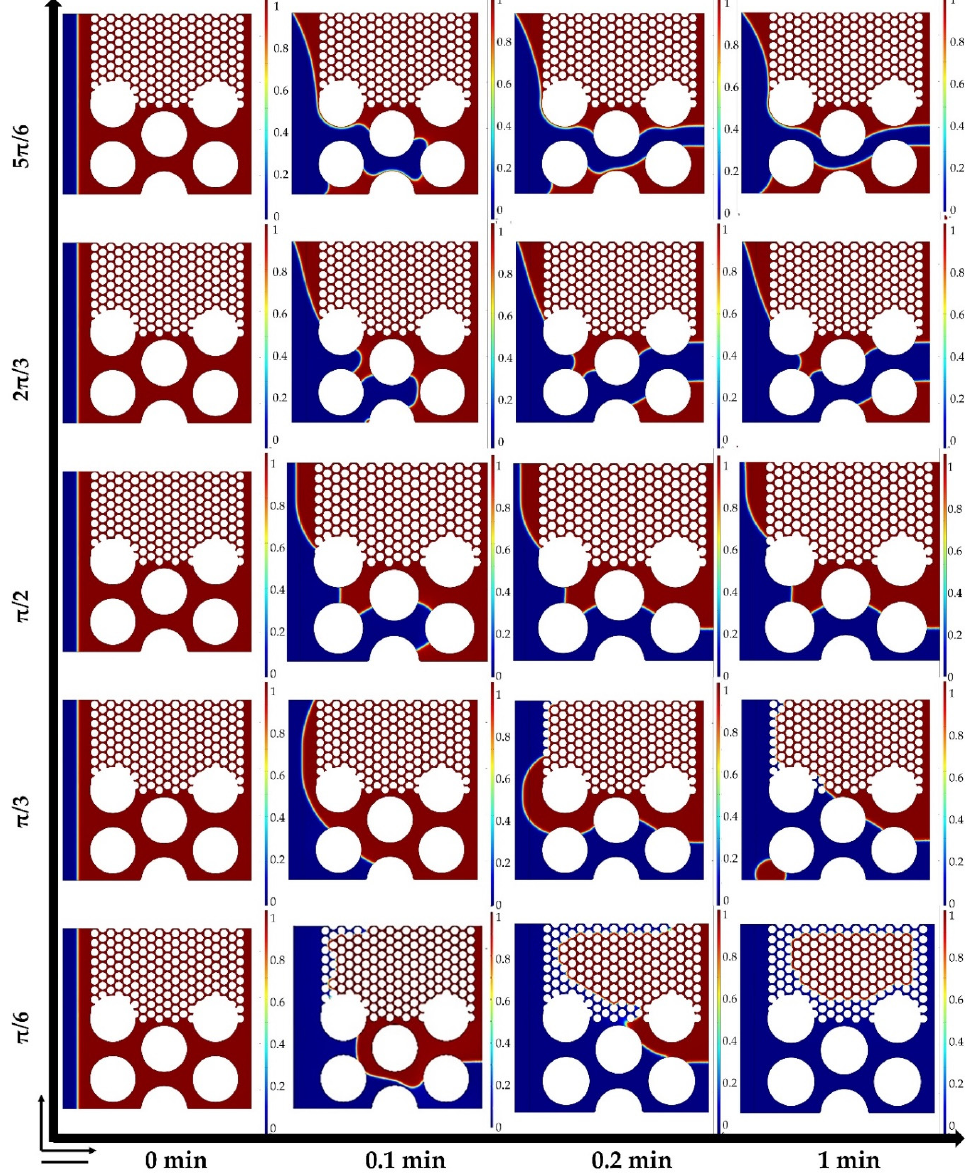
Figure 6. Oil volume fraction variation at a contact angle of (From top to bottom: 5 π /6; 2 π /3; π /2; π /3; π /6; from left to right: 0 min; 0.1 min; 0.2 min; 1 min). The scale bar is 1 mm.